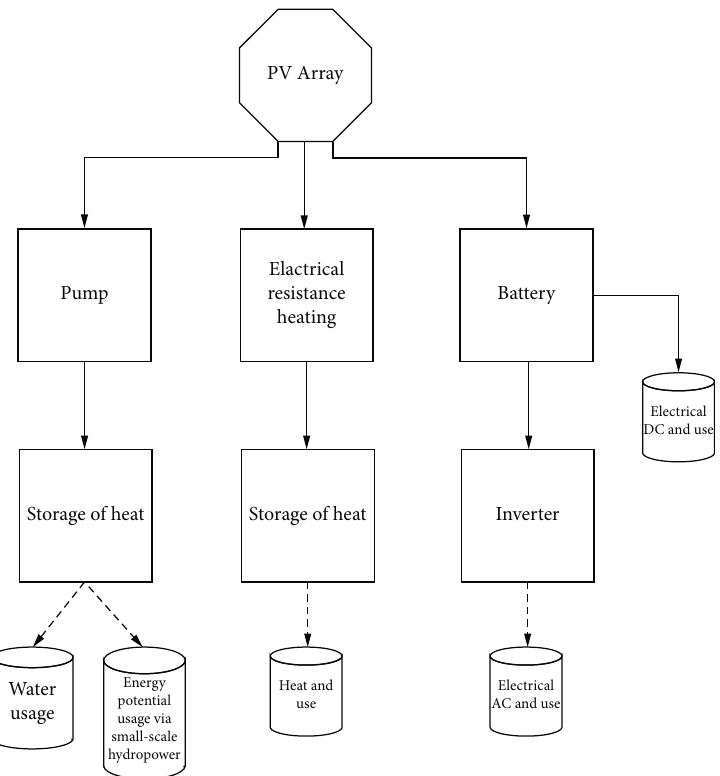
Figure 1: Photovoltaic energy storage